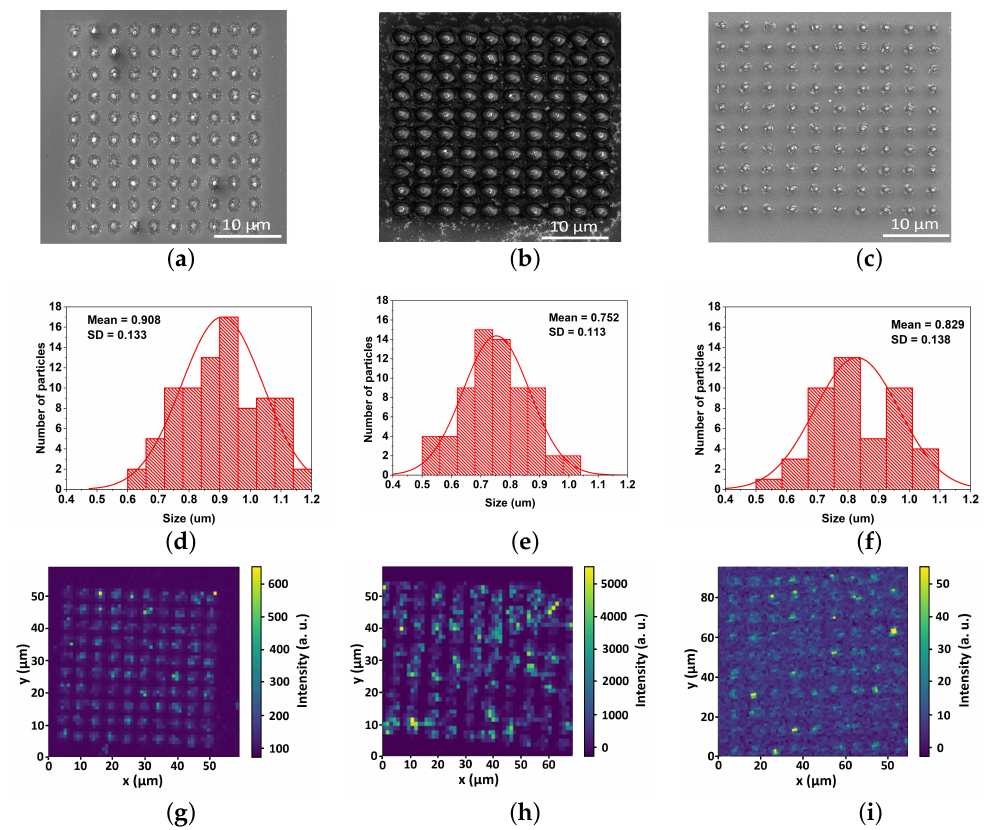
Figure 2. Arrays of hybrid NPs obtained from bi-layer Au/Si films with different thickness (first column—10/100 nm, second column—30/180 nm and third column—30/90 nm): ( a – c ) SEM images; ( d – f ) size distribution histograms with a mean size (mean) and the standard deviation of the size (SD); ( g – i ) PL signal mapping, brighter areas correspond to higher intensity at 600 nm